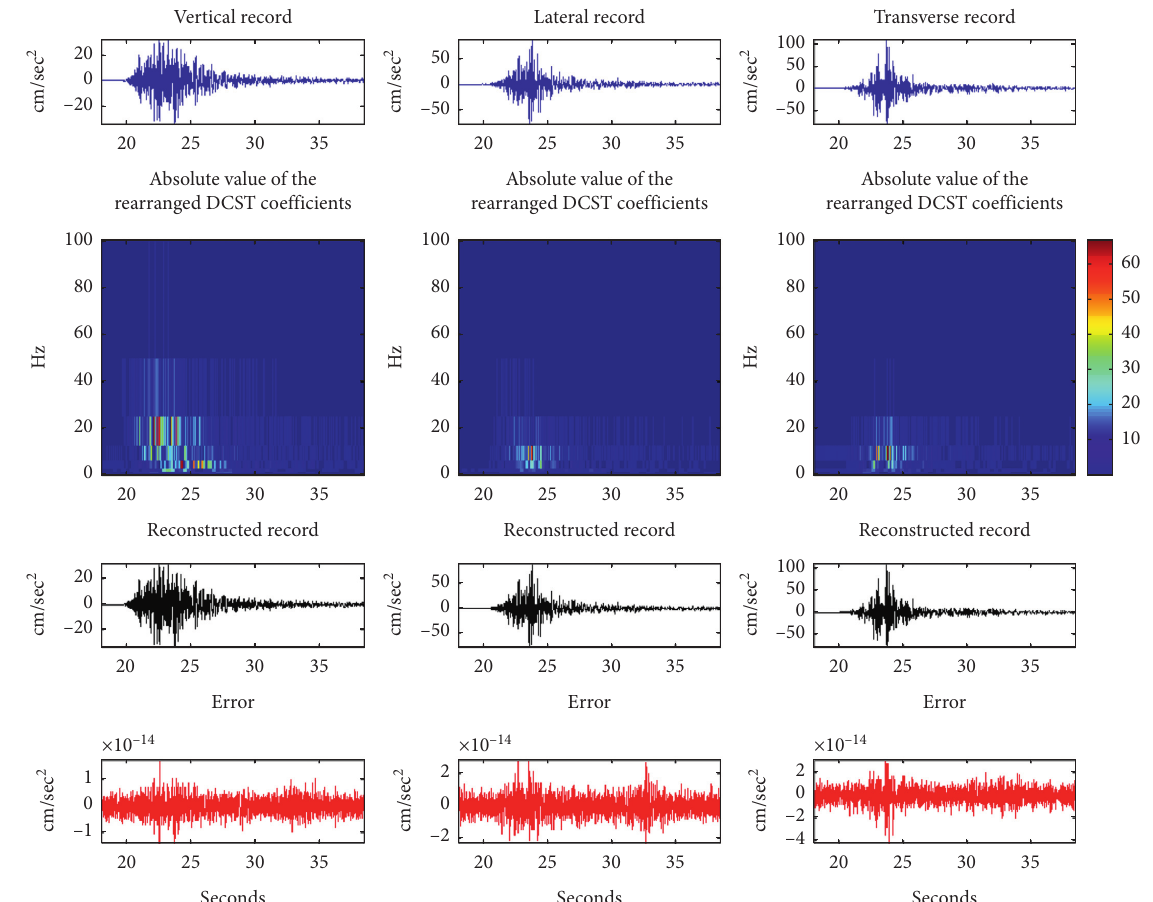
Figure 3: Discrete cosine S-transform analysis of the Mosha 2020 earthquake accelerograms recorded in Mosha3